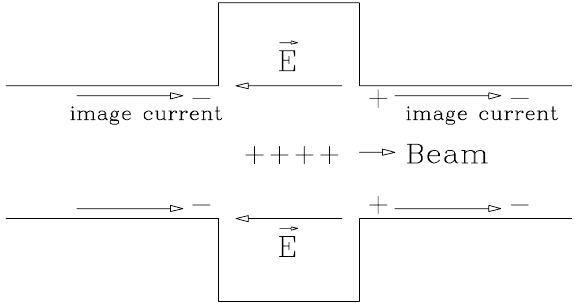
FIG. 11. As a positively charged bunch passes through a cavity, the image current leaves a negative charge at the upstream end of the cavity gap. As the image current resumes at the downstream side of the cavity, a positive charge is created at the downstream end of the gap because of charge conservation, thus setting up an electric field the transient beamloading voltage.